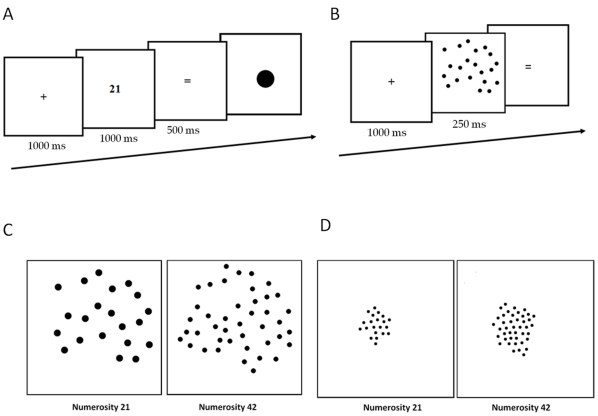
The numerosity production task (A) involving participants to perform a symbolic to non-symbolic mapping; and the numerosity perception task (B) involving participants to perform a non-symbolic to symbolic mapping.In the production task, the presentation of a single dot following the stimulus presentation corresponds to a signal for the participant to start their response production. Illustration of Extensive patterns of dots (C) and an Intensive pattern of dots (D) for numerosities 21 and 42.